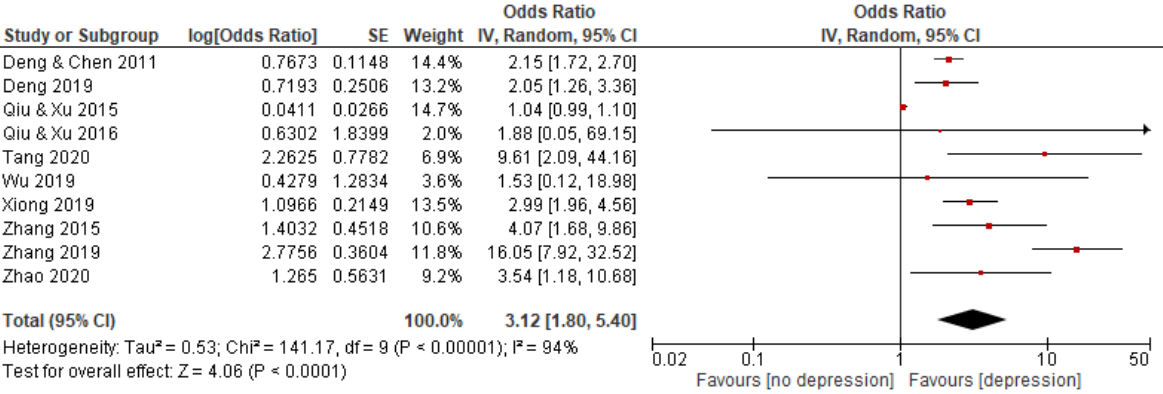
Figure 2. Forest plot of studies on association between QSC and depression. Note: red square represents the result of each study; line represents the 95% CI of the results; diamond represents the pooled results.